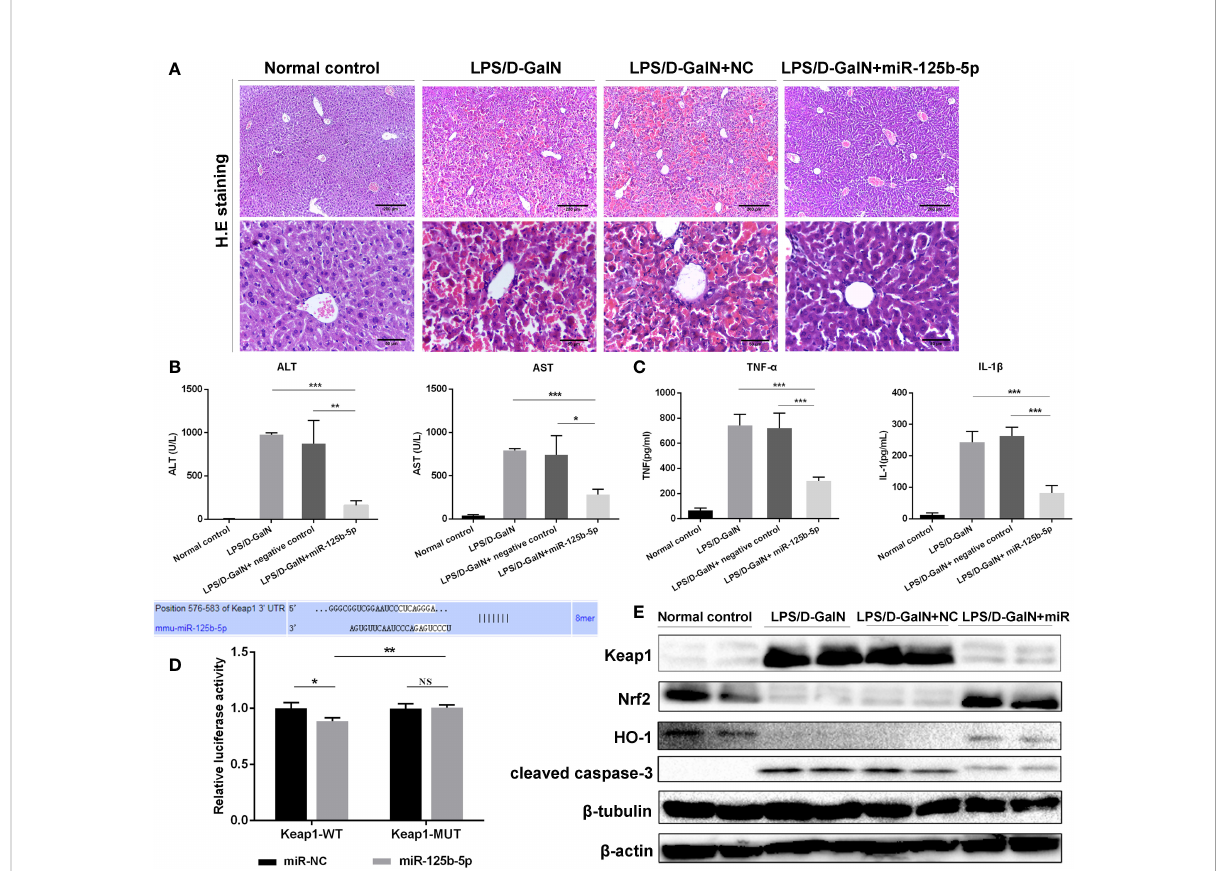
FIGURE 4 Role and mechanism of miR-125b-5p in LPS/D-GalN- induced ALF in vivo . (A) H&E staining of liver tissue. (B) Detection of serum ALF and AST. (C) Detection of two serum proin fl ammtory mediators, TNF- a and IL-1 b , using ELISA. (D) A luciferase reporter assay was performed to identify the binding sites between mouse Keap1 and mmu-miR-125b-5p. (E) The expression levels of Keap1, Nrf2, HO-1 and cleaved caspase-3 were evaluated by western blotting. NC, negative control. NS, no signi fi cance. * p <0.05, ** p < 0.01, *** p <